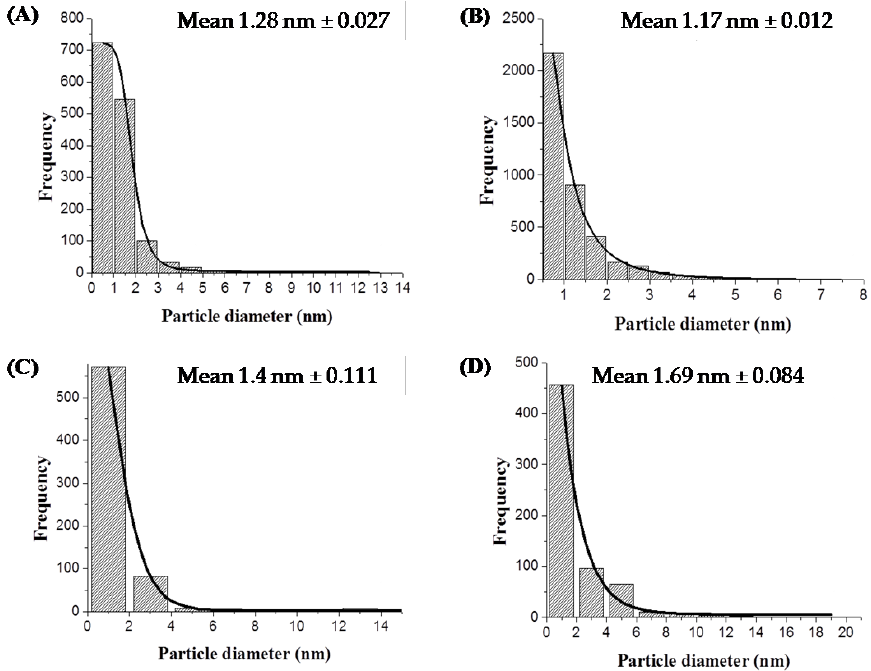
Figure 5. Size distribution and mean nanoparticle (NP) sizes of Pd nanoparticles made by E. coli MC4100 untreated ( A ) and MW-treated cells ( B ) and D. desulfuricans untreated ( C ) and MW-treated cells ( D ).The mean NP sizes (nm, mean ± SEM) were ( A ): 1.28 ± 0.027; ( B ): 1.17 ± 0.012; ( C ): 1.40 ± 0.11; ( D ): 1.69 ± 0.084.